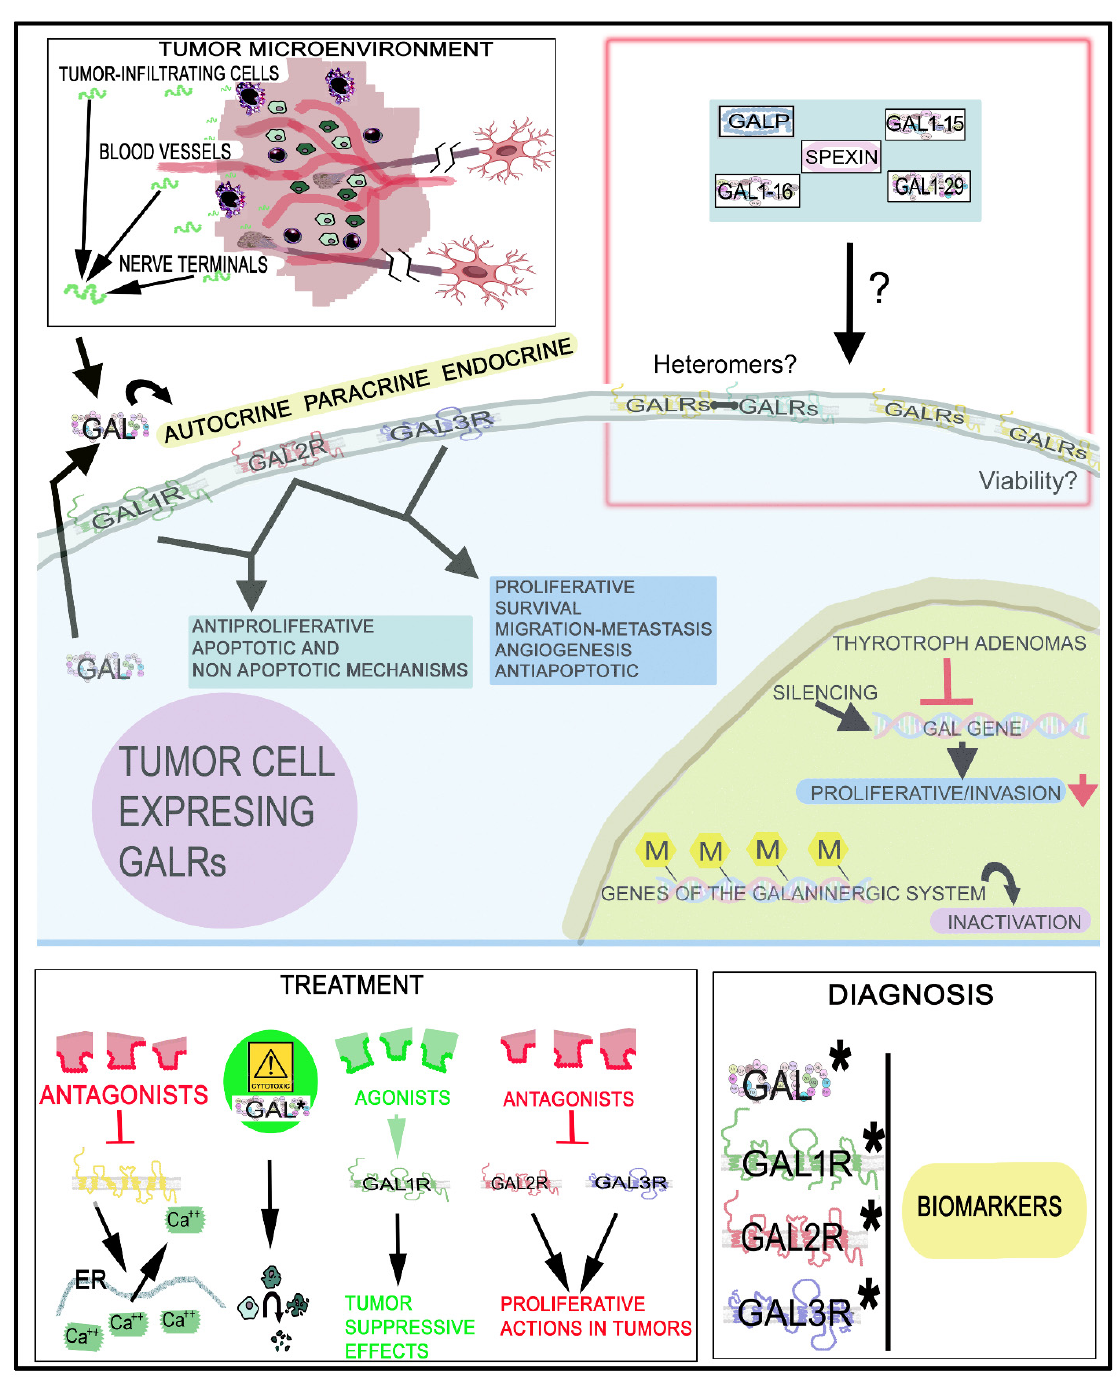
Figure 7. Involvement of the GAL/GALR system in cancer, diagnosis and treatment. GAL 1 R/GAL 2 R mediate an antiproliferative effect, whereas GAL 2 R/GAL 3 R promote a proliferative action on tumor cells. GAL originates from tumor cells, tumor-infiltrating cells and nerve cells. Circulating GAL can also bind to GALRs. ↑ : increase; ↓ : decrease; ?: mechanisms that must be investigated (presence/functions of heteromers in tumor cells, involvement of GALRs in the viability of cancer cells and involvement of GAL fragments and other peptides belonging to the GAL family of peptides in cancer). *, biomarkers; M: methylation.